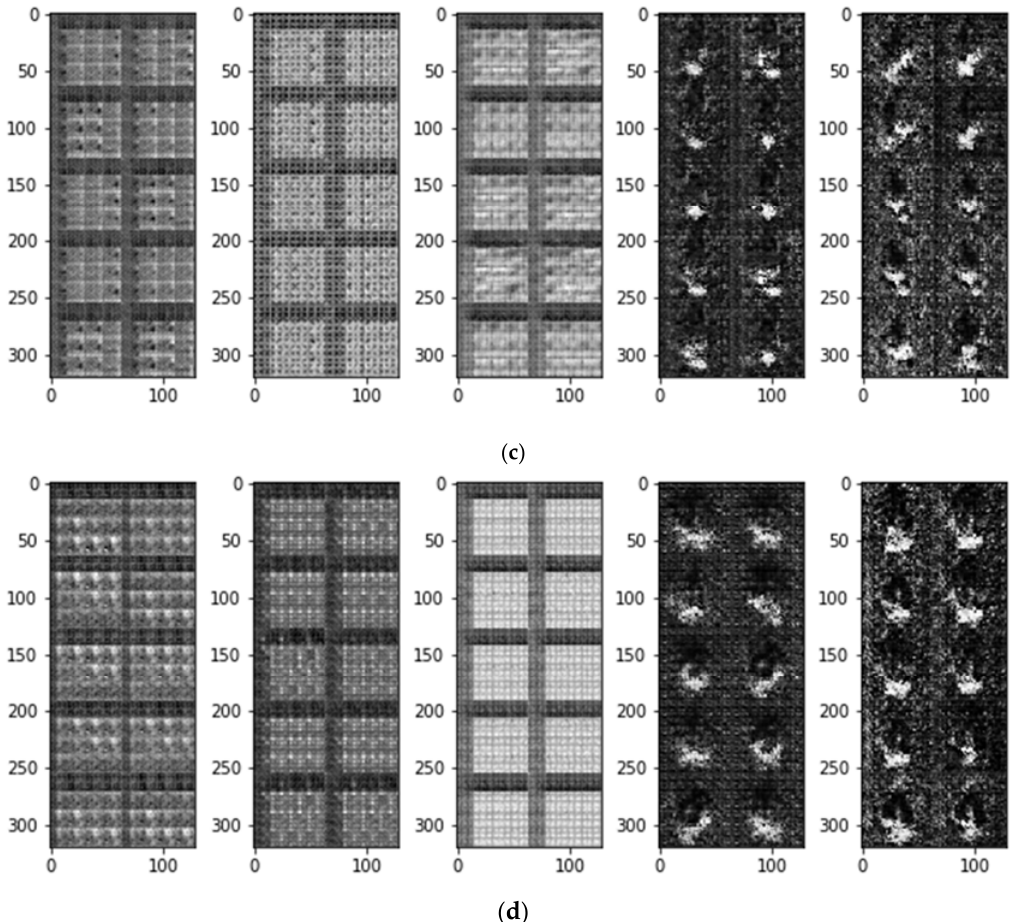
Figure 5. Original and generated SAR images: ( a ) Original SAR images; ( b ) 1099 original labeled images; ( c ) 824 original labeled images; and ( d ) 550 original labeled images. In ( b , c ), each group of images from left to right is generated in the 50th, 150th, 250th, 350th, and 450th epoch. Units of the coordinates are pixels.